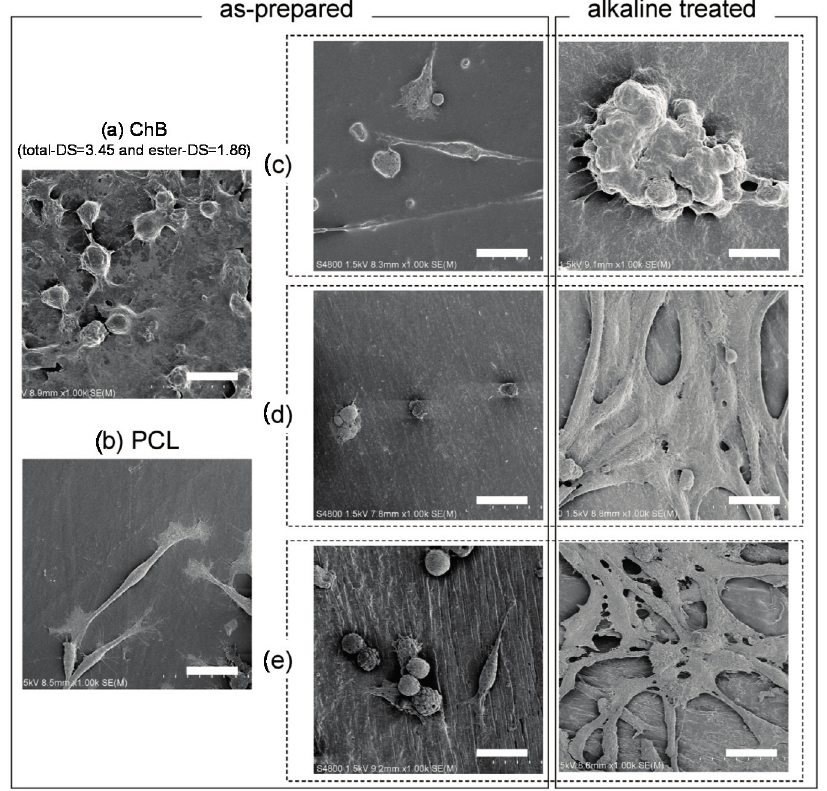
Figure 16. Field emission scanning electron microscope (FE-SEM) images of cell growth on films of ( a ) ChB (total-DS = 3.45; ester-DS = 1.86); ( b ) PCL; and ( c ) M; ( d ) PM, and ( e ) IM blends (original ChB/PCL weight ratio = 50/50). Images ( c )–( e ) include those of alkaline treated films. Scale bars denote 20 µm. Reproduced with permission from ref. [46]. Copyright 2014 Elsevier